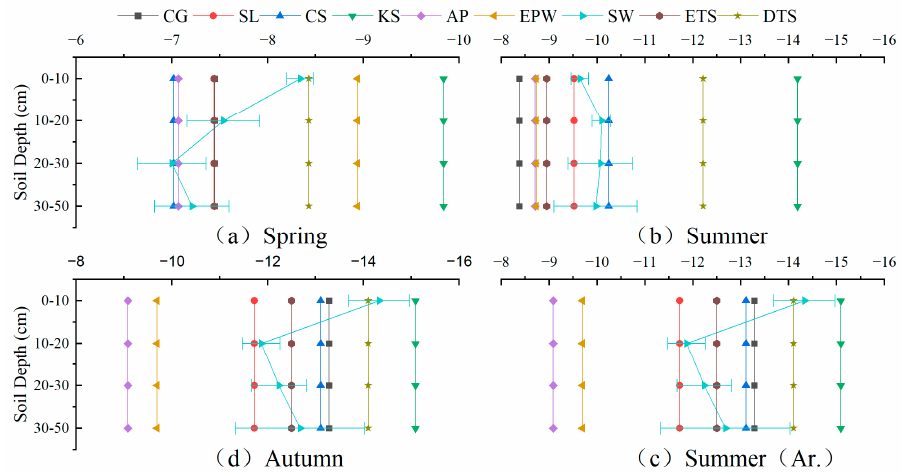
Figure 11. Correlation of plant xylem water, atmospheric precipitation, soil water and epikarstic water in different seasons. ( a ) In spring. ( b ) In summer. ( c ) In summer (Ar.). ( d ) In autumn. that of epikarstic water, and the top-down order was Cyclobalanopsis glauca ( − 8.38‰), Sym- plocos lancifolia ( − 9.52‰), Celtis sinensis ( − 10.24‰), and Kalopanax septemlobus ( −